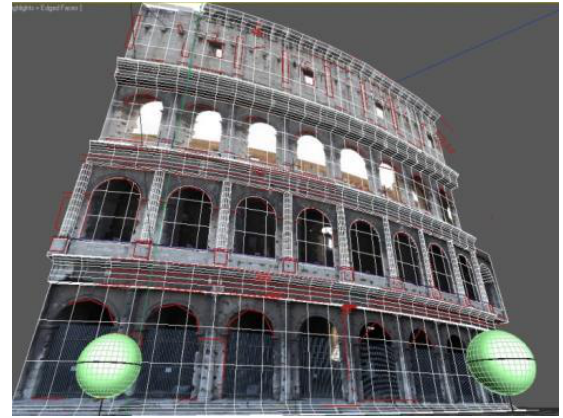
Figure15. Modeling aided by texture